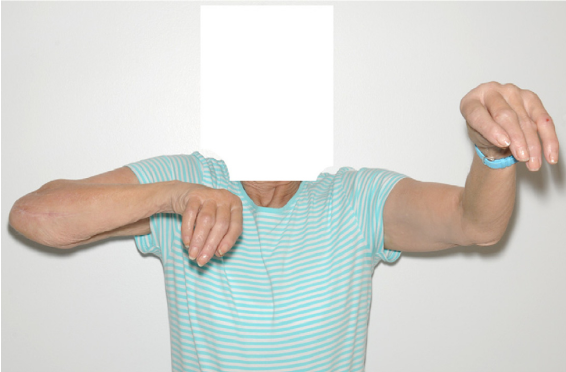
Figure 7. A front view clinical photograph for the third case showing active shoulder lateral